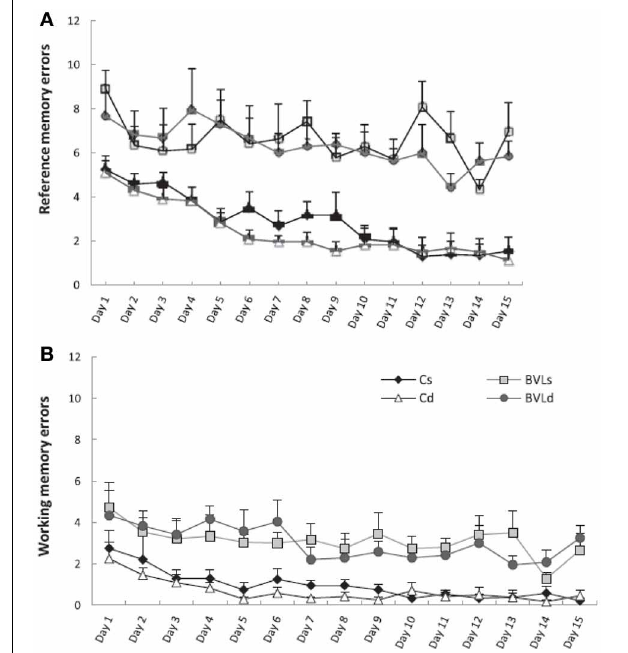
FIGURE 9 | Effects of 0.5mg/kg diazepam, which was shown to have an anxiolytic effects, on spatial memory performance in a radial arm maze of bilateral vestibular lesion (BVL) and sham C rats. (A) Number of reference memory errors. (B) Number of working memory errors. Cs, control saline; Cd, control diazepam; BVLs, BVL saline; BVLd, BVL diazepam. Diazepam did not reduce the spatial memory deficits of the BVL rats. Data are expressed as means ± s.e.m. Reproduced with permission from Machado et al.